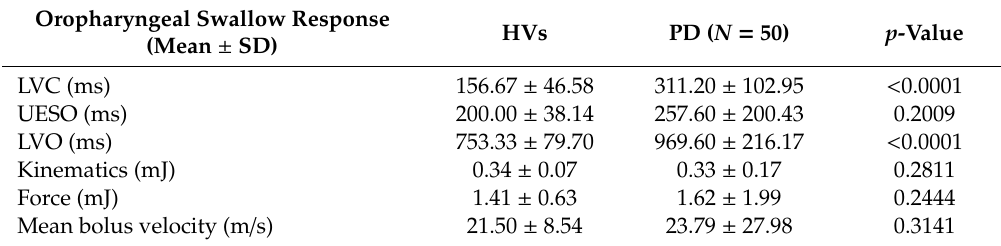
Table2. OropharyngealswallowresponseasevaluatedbyvideofluoroscopyinpatientswithParkinson’s disease (PD) in the ON state and healthy volunteers